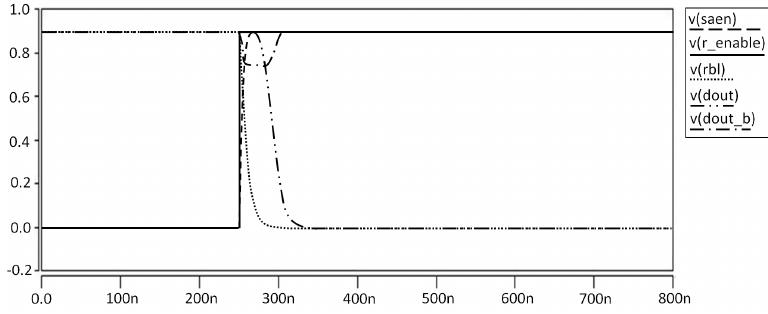
Figure 19. Waveform of Reading 0 operation in CNFET.